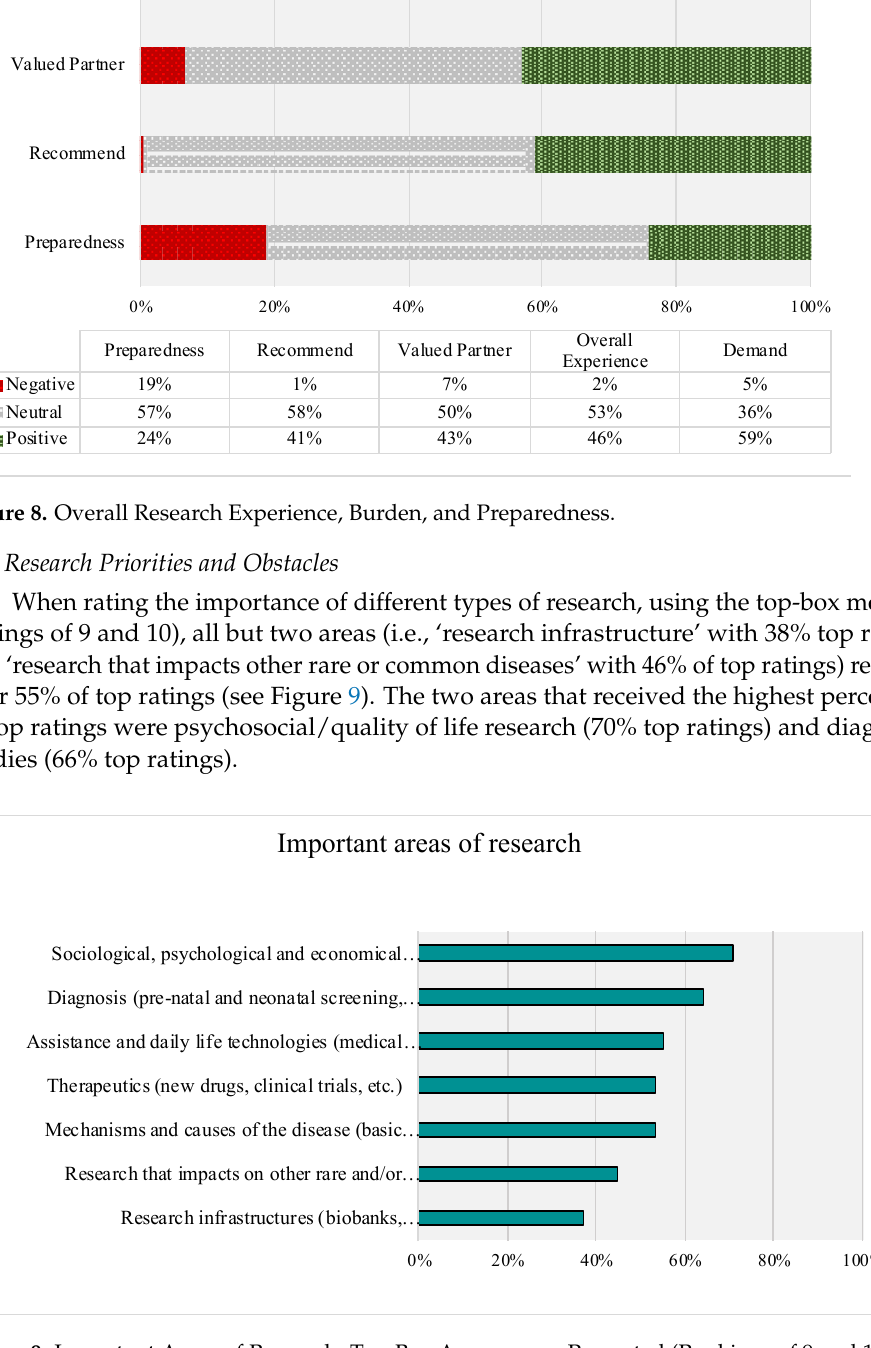
Figure 9. Important Areas of Research. Top ‐ Box Answers are Presented (Rankings of 9 and 10).